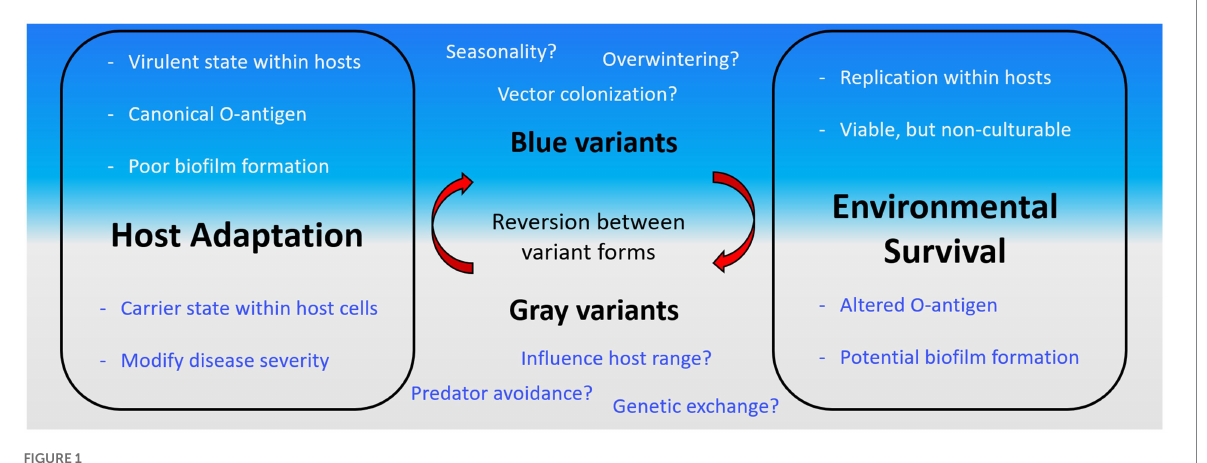
FIGURE 1 Traits of Francisella tularensis antigenic variation and outstanding questions. F. tularensis is known to transition between a “blue” or “gray” state by altering the O-antigen. The properties of these states are outlined in each box (Host Adaptation, left; Environmental Survival, right) grouped by where trait likely aids the bacterial cell. The traits are further separated within these boxes based on the associated state of the cell (blue, top; gray, bottom). Outstanding aspects of F. tularensis biology where phase variation is potentially important are displayed in blue or gray